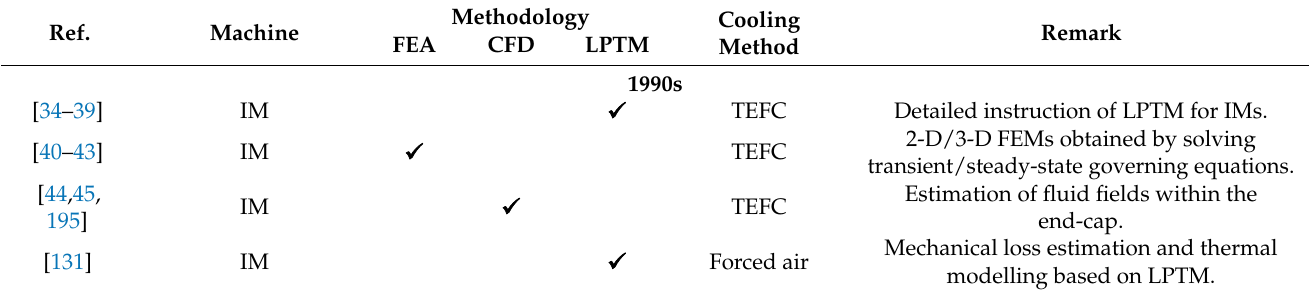
Table A1. Review of some thermal analysis literature for electrical machines. Ref.